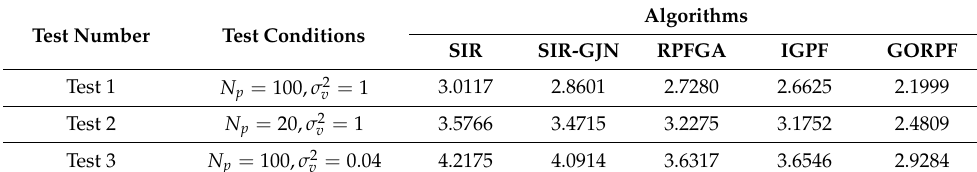
Table 4. The RMSEs (m) of the five particle filter-based algorithms in different test conditions.